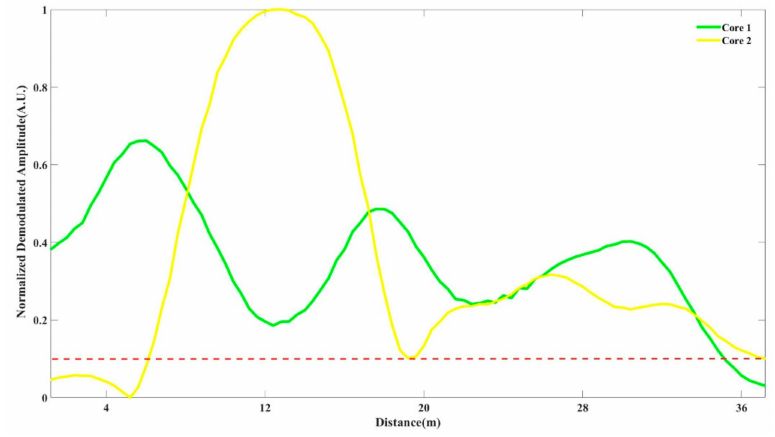
Figure 3. Signal amplitude fluctuation in different fiber